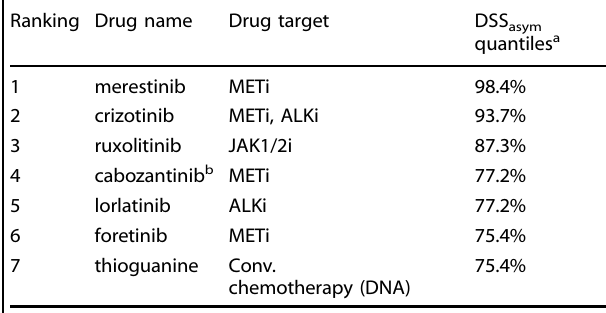
Table 1. Drug hits with above-average drug response (quantile ≥ 75%) for case #1 relapse 3